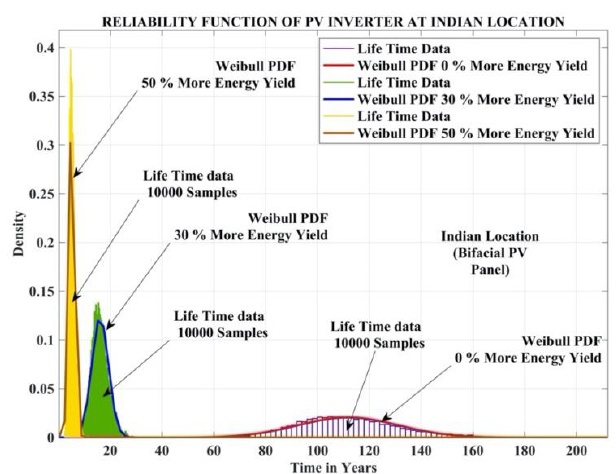
Figure 19. Lifetime distribution of the PV inverter at the location in India.